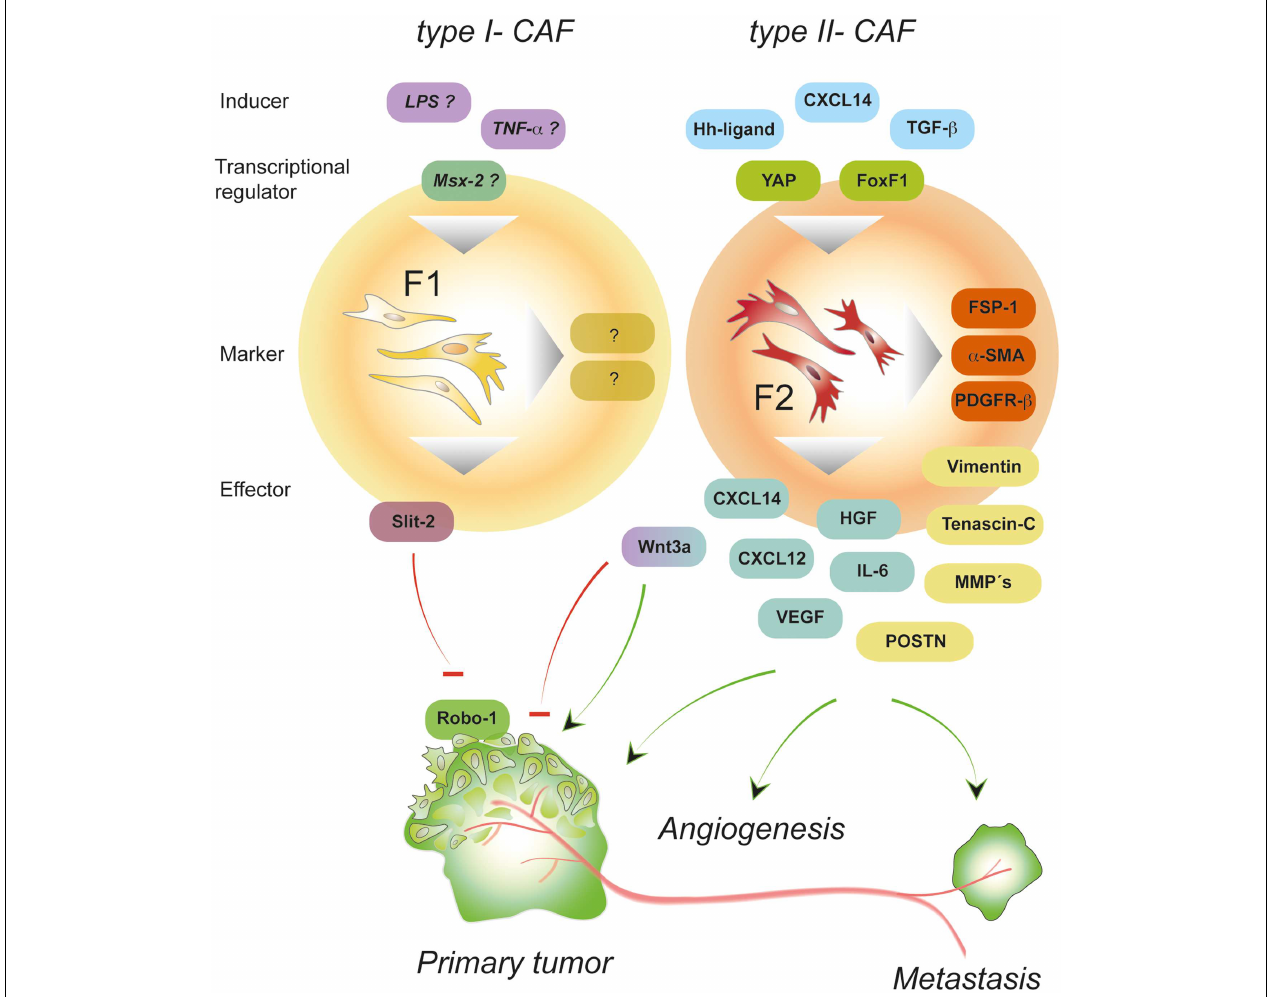
effects by stimulating other cells in the environment of the local tumor and beyond. In contrast, type I polarized fibroblasts (F1)-expressing molecules such asWnt3a and Slit2 can exhibit tumor-inhibitory effects by suppressing the action of cancer cells. About the exogenous signals and transcription factors involved in establishing the tumor-suppressive phenotype can only be speculated so far. Potential inducers of type I-CAFs areTNF- α and LPS that have been shown to stimulateWnt3a and chemokine expression, respectively